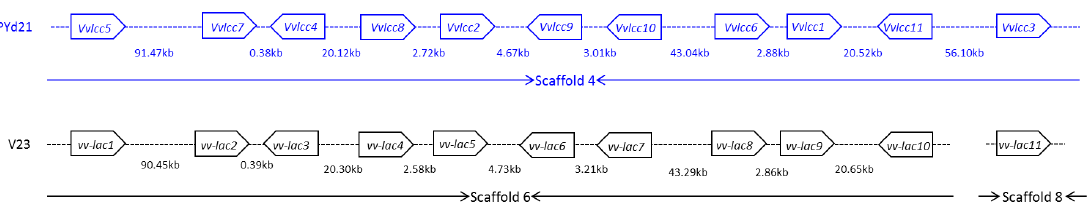
Figure 1. Distribution of laccase genes in the genome of V. volvacea strain PYd21 and V23. Arrow-shaped boxes indicate the laccase genes, whereas the direction of arrows shows the direction for each gene. The numerical values below the line indicate the distances (bp) between pairs of laccase genes. Blue boxes indicate laccase genes from the PYd21; black boxes indicate laccase genes from V23.